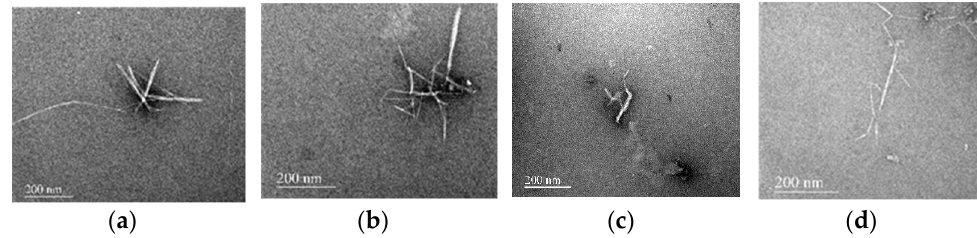
Figure 9. TEM images of the pretreated cotton fiber at different growth stages, ( a ): XM-1, ( b ): XM-2, ( c ): XM-3, ( d ): XM-4.